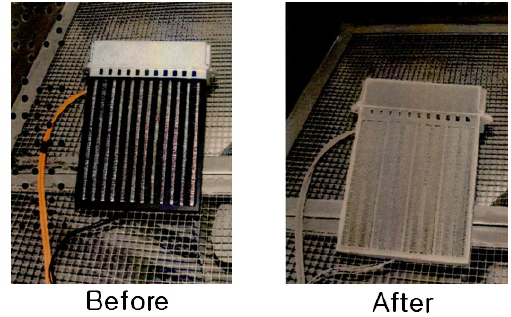
Figure 10. External appearance of a prototype of the heating system before and after an impact test.